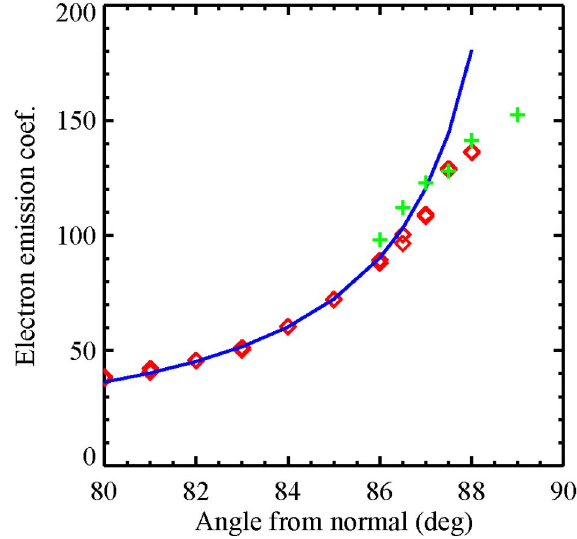
FIG. 9. (Color) Electron emission coefficient as a function of angle of incidence measured from normal for a baked target. Red diamonds indicate measurements (at least two data points per angle), the blue line is given by 6 : 3 = cos (cid:2) (cid:4) (cid:3) , the green (+) points are scaled with the SRIM code as in Eq. (8)